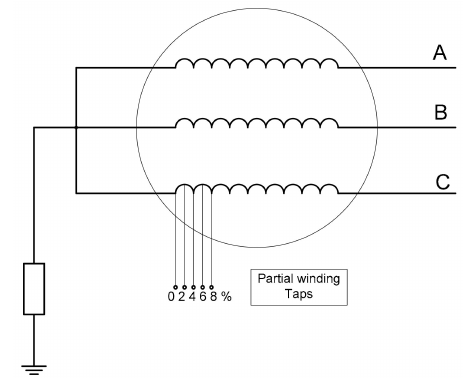
Figure 4. Synchronous machine stator connections.